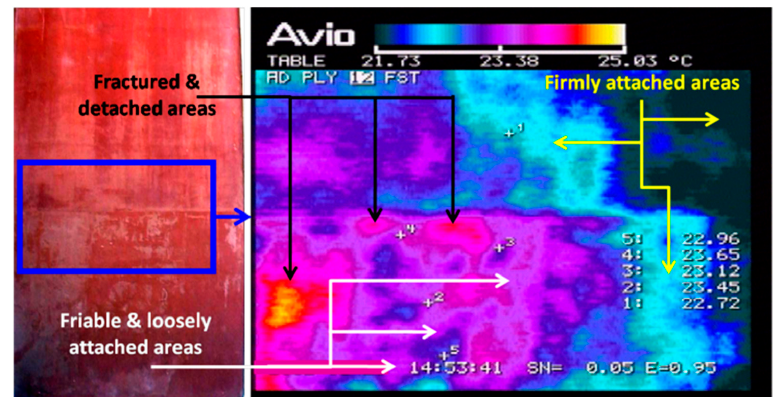
Figure 21. Plastered area under investigation and corresponding IRT image.